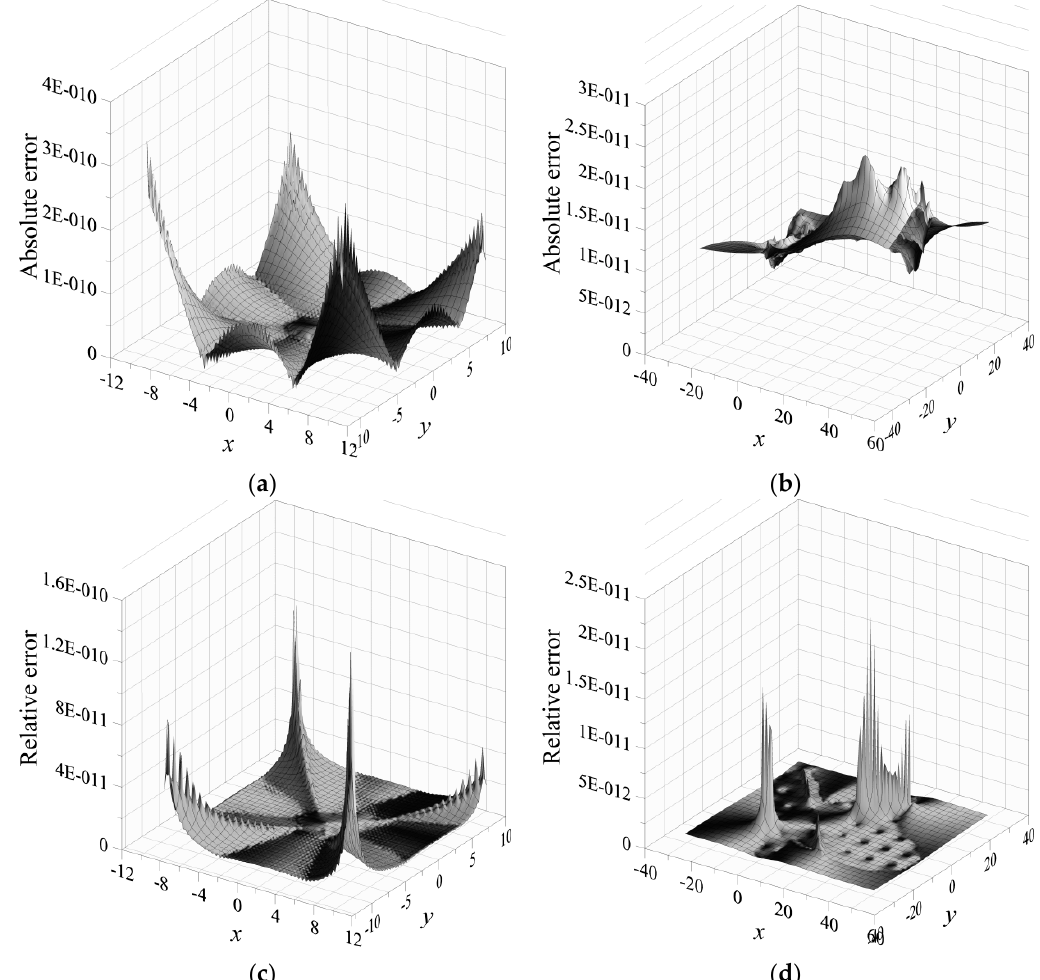
Figure 22. Comparison of results with the analytical solution. ( a ) Absolute error in the first layer, ( b ) absolute error in the second layer, ( c ) relative error in the first layer and ( d ) relative error in the second layer.